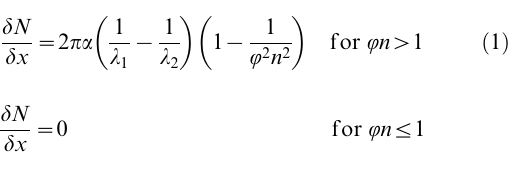
Table 2. Ac-225 daughters abundance of emissions and those having energy greater than the CR threshold.